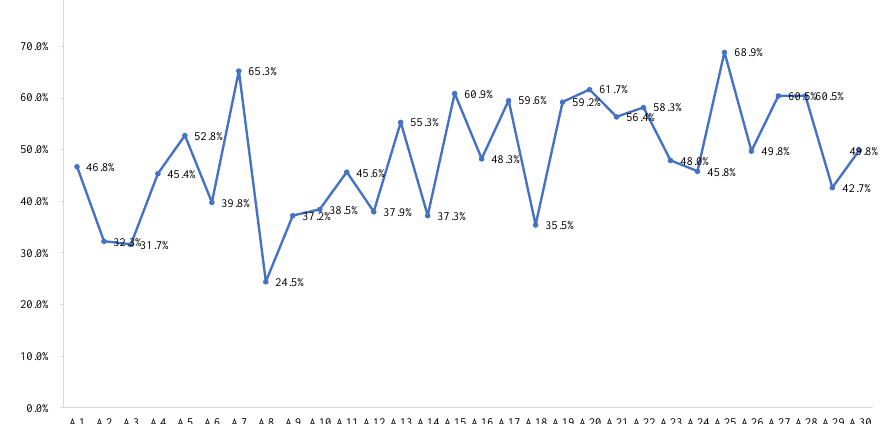
Figure 8. Proportion of direct energy use in the embodied energy use of transportation sector. • Provincial perspective